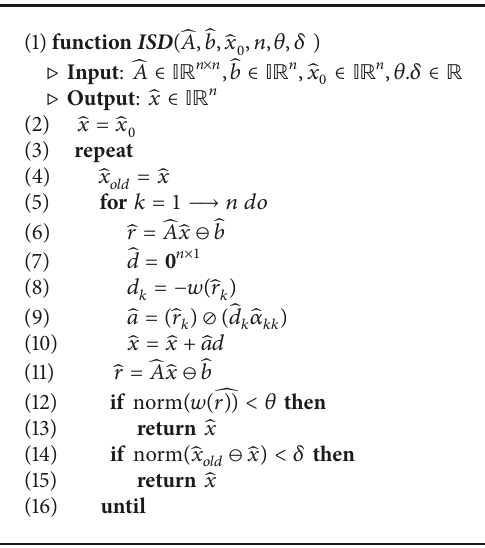
Algorithm 3: Interval steepest descent